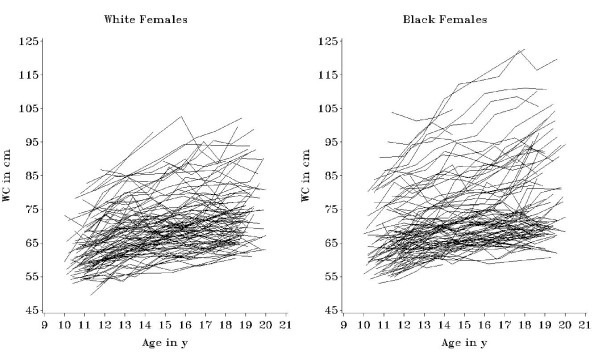
Individual waist circumference trajectories. Waist circumference trajectories for a randomly selected subset of 100 black and 100 white NGHS adolescent females